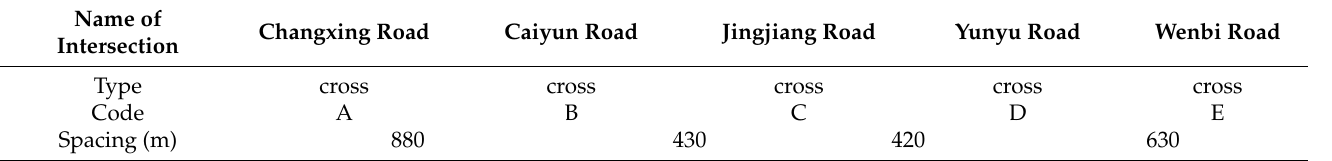
Table 1. Basic data of each intersection on Ziwu